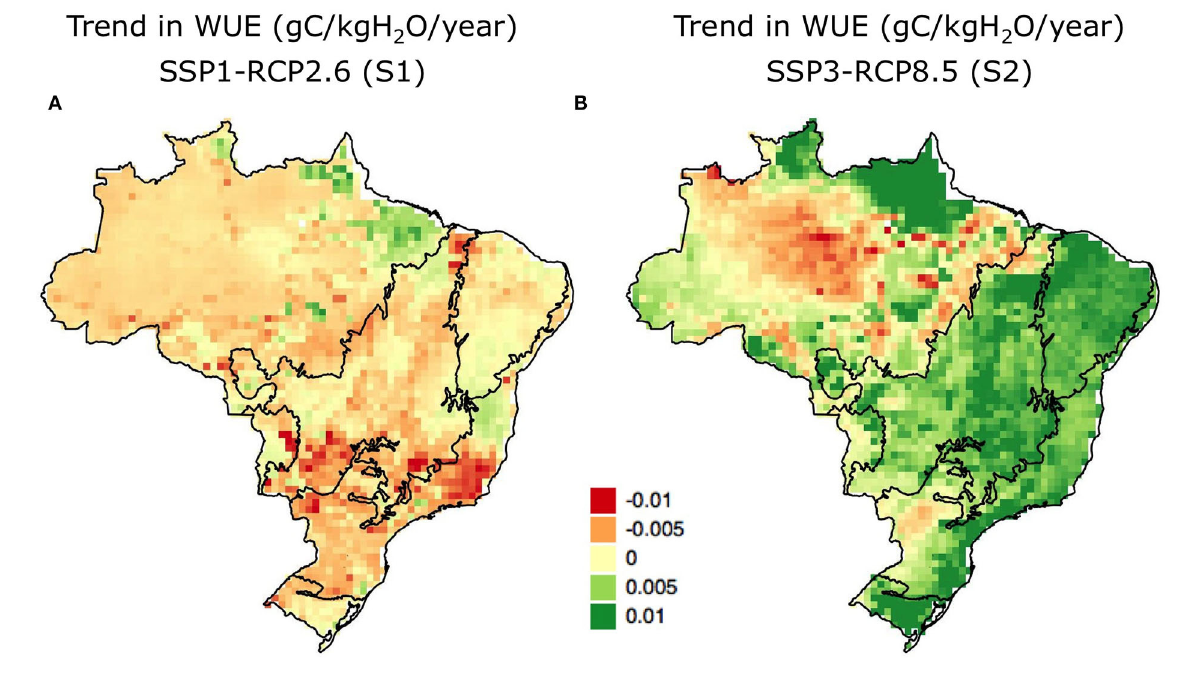
FIGURE10 Trend coefficient in the WUE (gC/kgH2O/year) for (A) SSP1-RCP2.6 (S1) and (B) SSP3-RCP8.5 (S2).